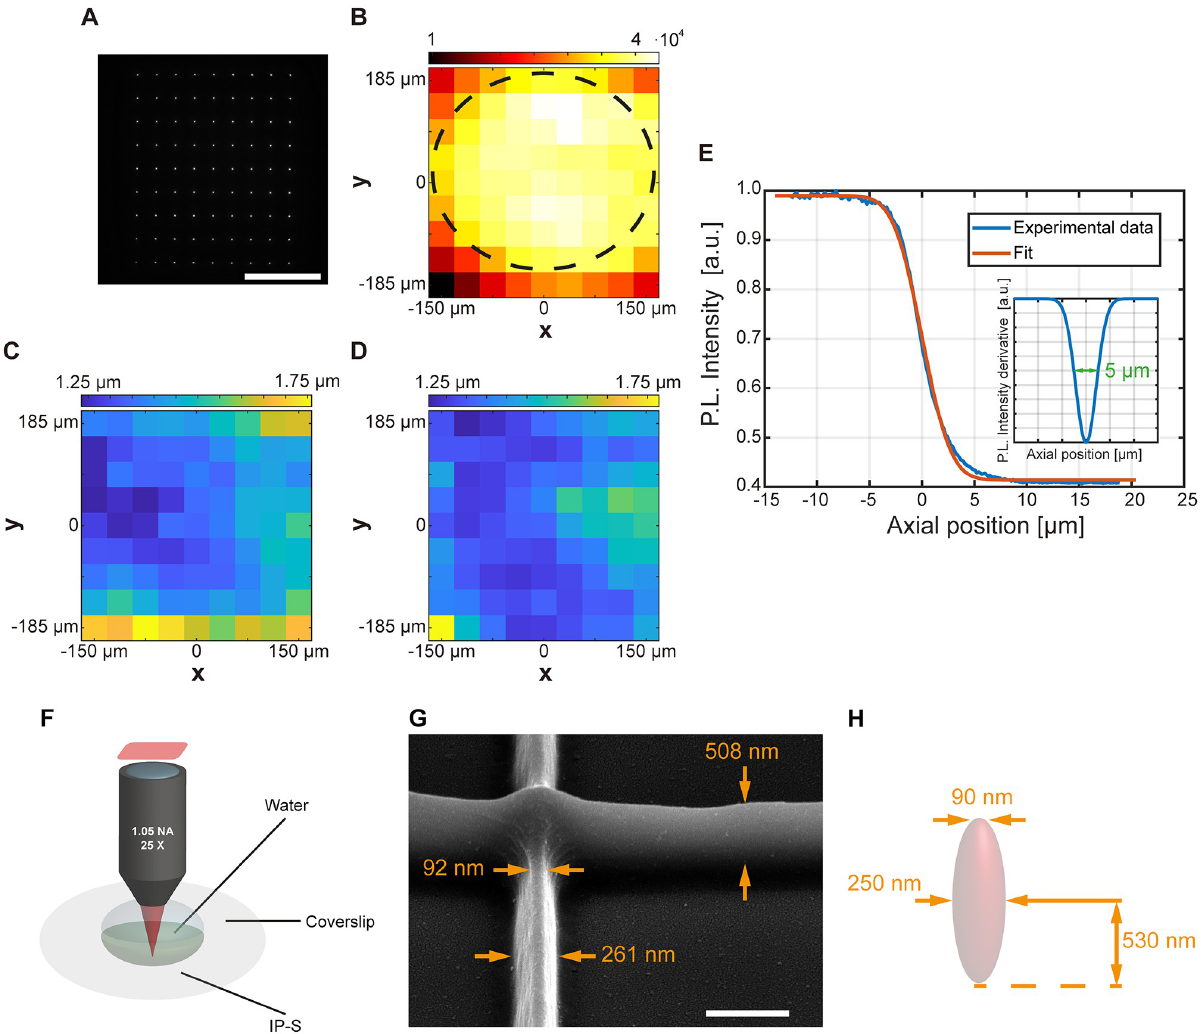
Fig 3. Spot characterization. (A) Matrix of fluorescence spots with 785 nm femtosecond laser excitation. Scalebar is 150 μ m (B) Maximum intensity maps of the fluorescence spots in (A). The black dashed line highlights the region with standard deviation less than 5%. (C) x dimension map of the fluorescence spots in (A). (D) y dimension map of the fluorescence spots in (A). (E) Estimation of the axial size of the spot. (F) Water-coverslip- photoresist configuration used for structure fabrication with the water immersion objective. (G) Details of the minimum line thickness of ~90nm achieved with laser power 14.1mW at the sample plane (estimated power density of 7.18 TW/cm 2 [23]) and writing speed 0.01mm/s. Scalebar is 500nm; sample is tilted by 45˚. (H) Schematic representation of the polymerizing voxel. Each dimension is obtained as average on n = 5 measurements, standard deviation is 5% for voxel diameters (both central and superficial) and 4% for voxel half-height. spots matrix excited in the fluorescent drop, recorded by scanning the focused laser beam while exposing the sCMOS camera for a time long enough to capture all the matrix elements. For each focused spot, both intensity and beam size were evaluated. As shown by the color map in Fig 3B, beam intensity has a standard deviation below 5% in a circular region of diame- ter 300 μ m (outlined by the black dashed), that increases to < 15% if a square 300 μ m x 300 μ m field is considered. The size of each fluorescence spot was then analyzed by extracting the intensity profile along the x and y axes to compute the related full width at half maximum (FWHM) distribution, reported in Fig 3C and 3D. Across the 300 μ m x 300 μ m field, average FWHM was estimated to be 1.36 μ m with a standard deviation 0.09 μ m, on a total of n = 144